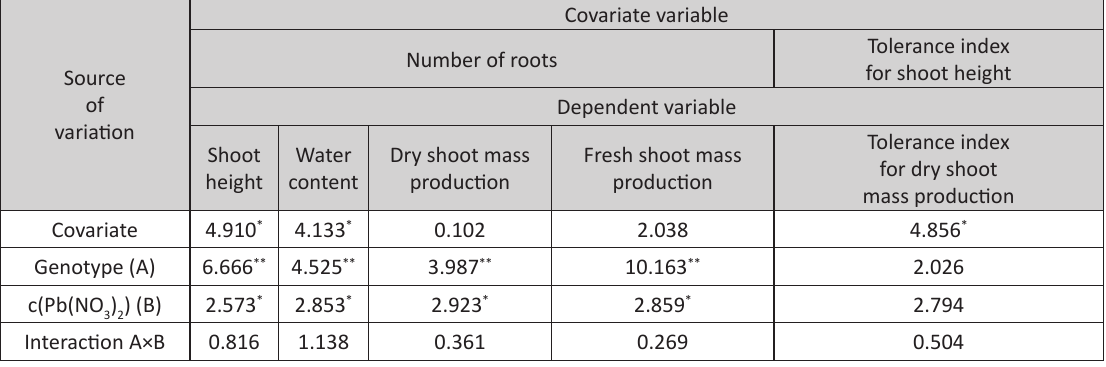
F-test from the analysis of covariance for some characters of interest for lead tolerance in white poplar genotypes